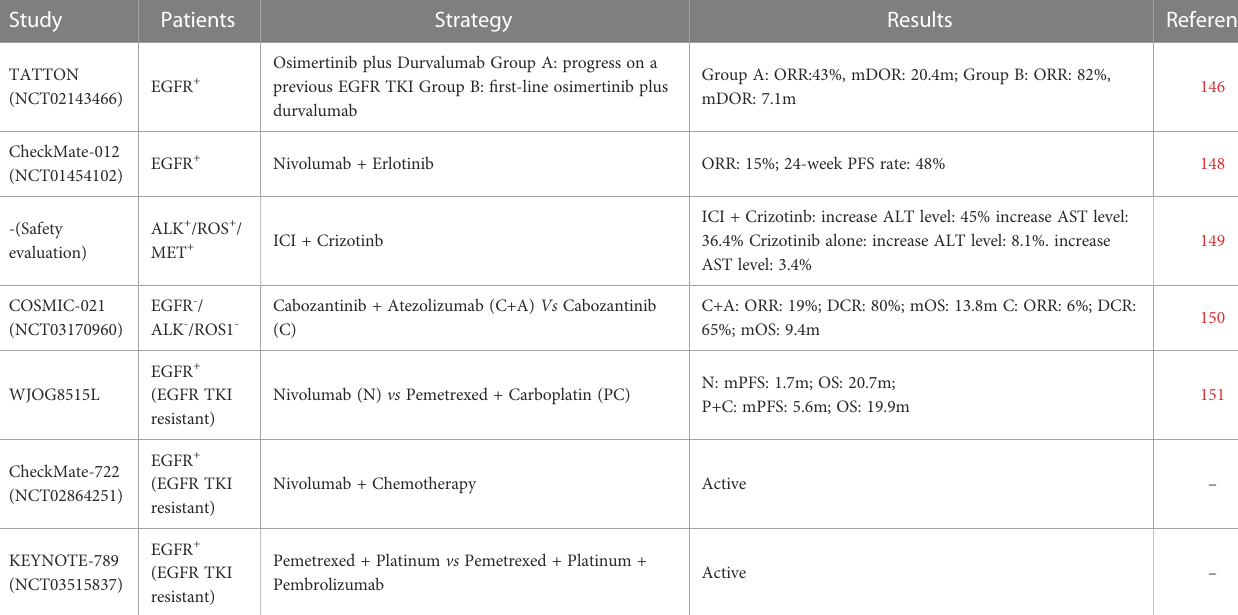
TABLE 1 Clinical trials investigating the effects of ICIs in driver mutation-positive NSCLC. Study Patients Strategy Results